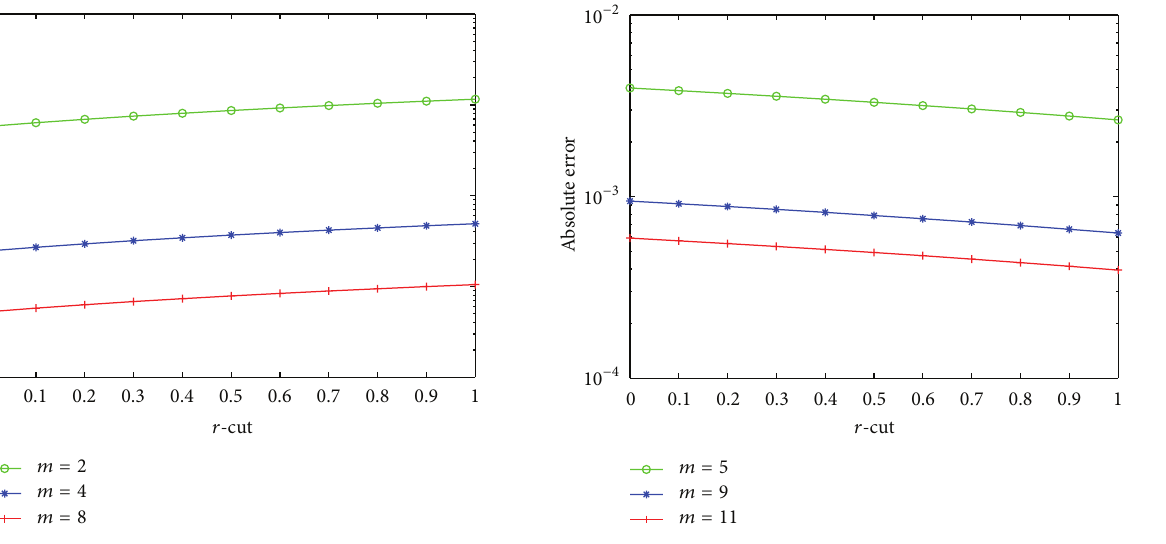
Figure 4: The Absolute Error for different 𝑚 of Example 52, Case 2. 𝛼 = 0.75